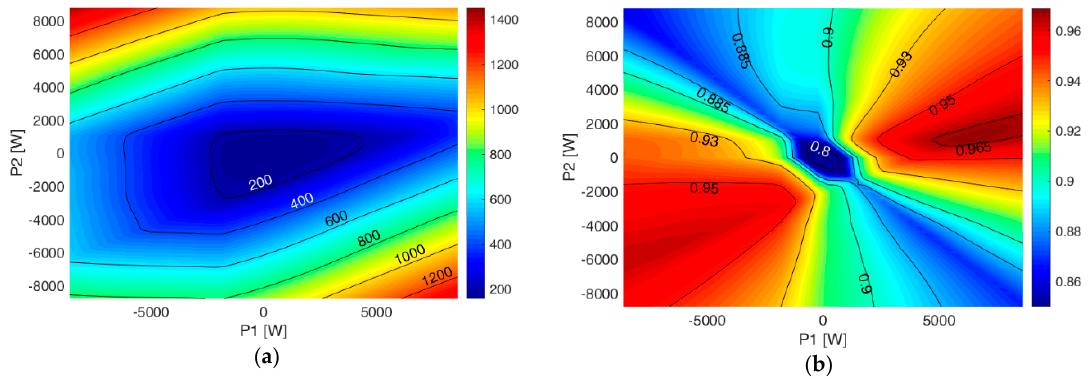
Figure 8. 3SC ( a ) Losses [W] ( b ) Efficiency.